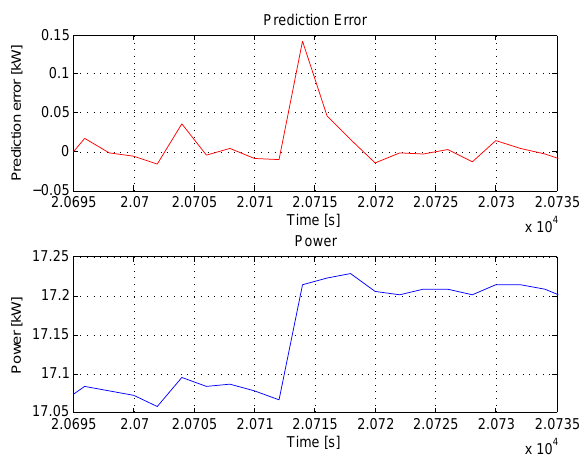
Figure 5: Residuals, e , (upper) and measured power, ∆ P , (lower) zoomed in at the right-most ar- row in Figure